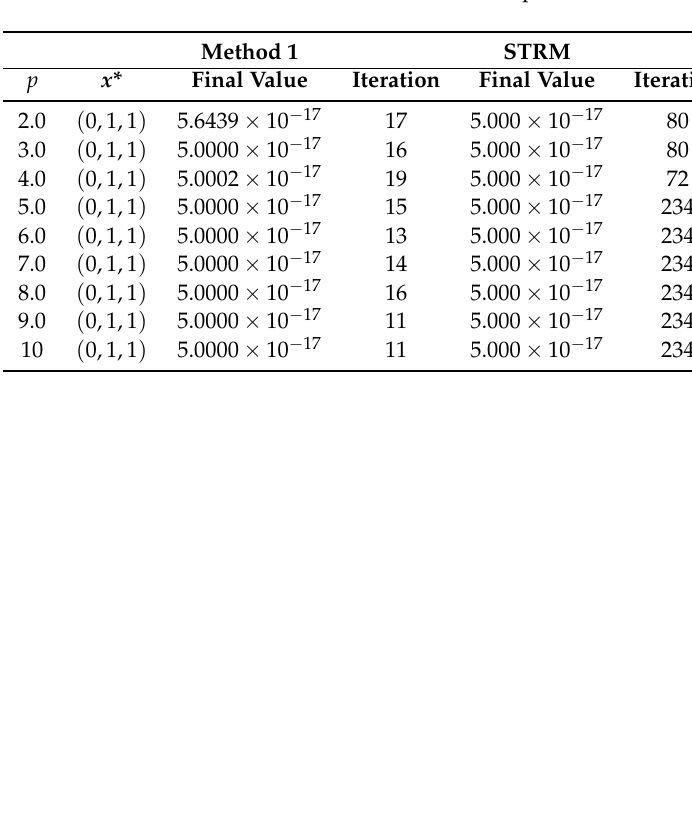
Table 3. Numerical results for Example